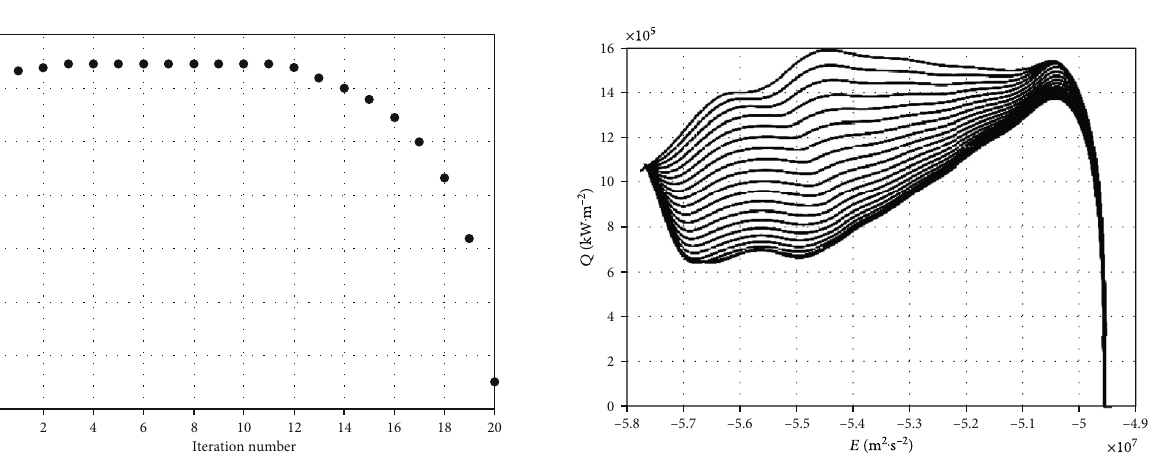
Figure 25: Dispersion of the terminal velocity.